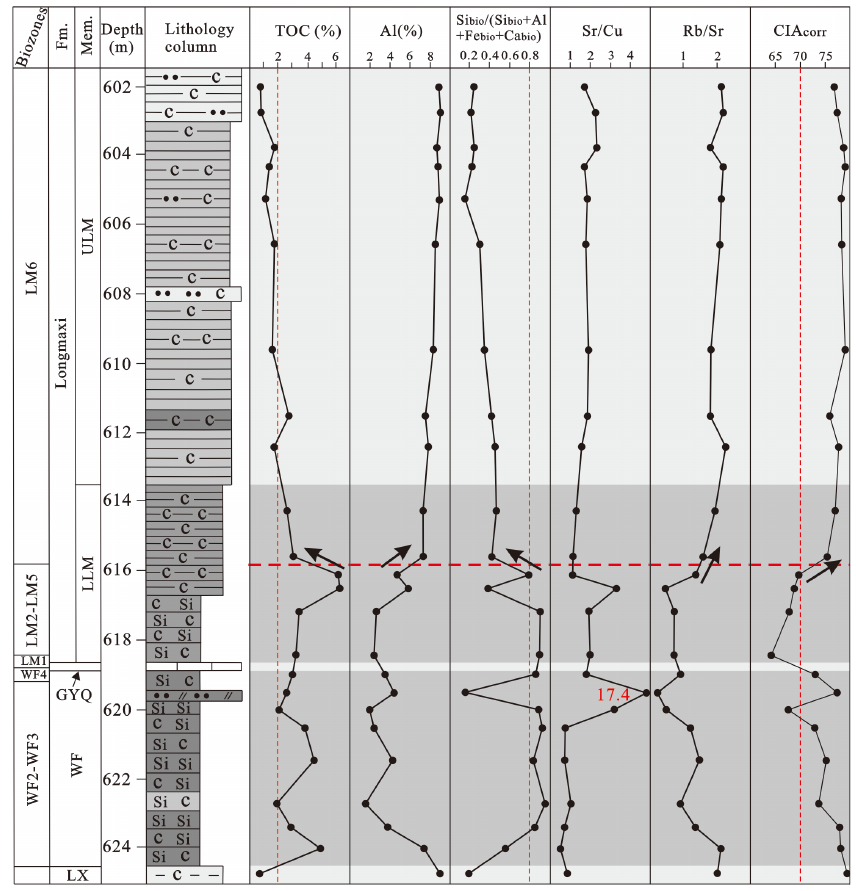
Figure 7. Vertical variation in TOC contents, terrigenous influx proxy Al contents, biogenic source discrimination proxy Si bio /(Si bio + Fe bio + Al + Ca bio ), palaeoclimate proxies Sr/Cu and Rb/Sr, and CIA corr of the Wufeng – Longmaxi Formation in well YD1, showing that the organic - rich shales in the WF and LLM mainly deposited in the warm and humid climate, and the organic - lean shales in the LX and ULM mainly deposited in a warmer and wetter climate. Remarkably, the significant variation of palaeoenvironment caused by the Kwangsian Orogeny [20,21] directly led to the turnover of graptolite biozones from the LM5 in Rhuddanian to the LM6 in Aeronian. Note: The red dotted line represents the boundary of Rhuddanian and Aeronian.